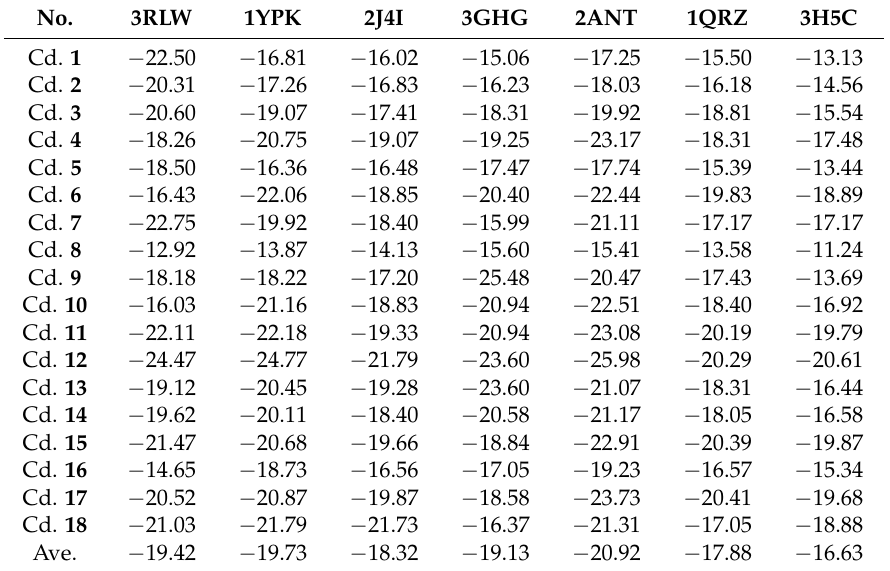
Table 7. The binding energies (kJ · mol − 1 ) of the 18 phenolic acid derivatives with seven protein targets. No.